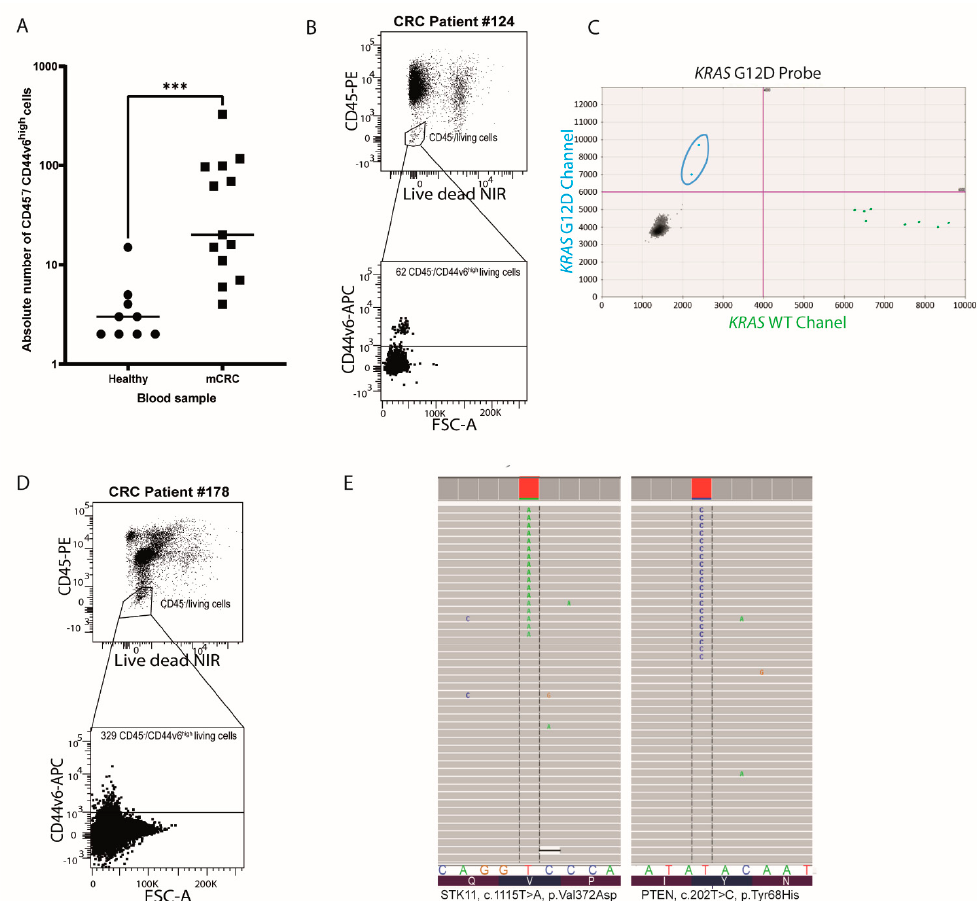
Figure 4. CD44v6 high /CD45 − CTCs can be purified from CRC patient blood samples by cytometry. ( A ) Dot plot representing a significantly higher number of CD44v6 high /CD45 − cells in the blood of CRC patients ( n = 13) compared to the blood of healthy subjects ( n = 9). The number of CD45 − /CD44V6 high cells in the different groups was compared using the nonparametric unpaired Mann–Whitney U test (2-tailed, confidence interval of 95%, *** p value = 0.0001). ( B ) FACS plot demonstrating the presence of live CD45 − /CD44V6 high cells in the blood of patient no. 124. NIR stands for “near infra-red”. ( C ) DNA was extracted from the latter cells for digital droplet PCR. Scatter plot of the digital droplet PCR results shows fluorescent detection of individual droplets. Green (x-axis) and blue (y-axis) dots represent droplets with KRAS WT and KRAS G12V (surrounded in blue) genotypes, respectively. ( D ) FACS plot demonstrating the presence of live CD45 − /CD44V6 high cells in the blood of patient no. 178. ( E ) DNA was extracted from the latter cells for next-generation sequencing. ( E ) Molecular alterations detected by sequencing in the blood of patient no. 178. The STK11 V372D mutation was present at 8.7% ( left ), and the PTEN Y68H alteration was detected at 6.2% ( right )—visualized using the Integrative Genomic Viewer